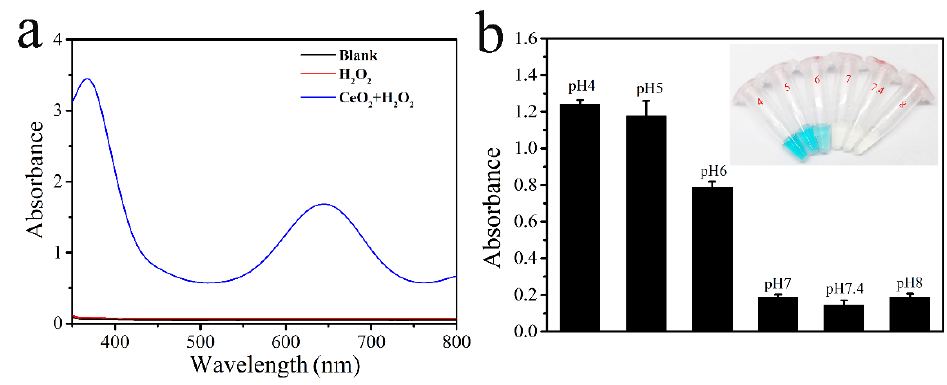
Figure 2. The assay of peroxidase activity of CeO2. ( a ) The absorbance of TMB at 652 nm right in different reaction systems; ( b ) the effect of different pH on absorbance of TMB at 652 nm.